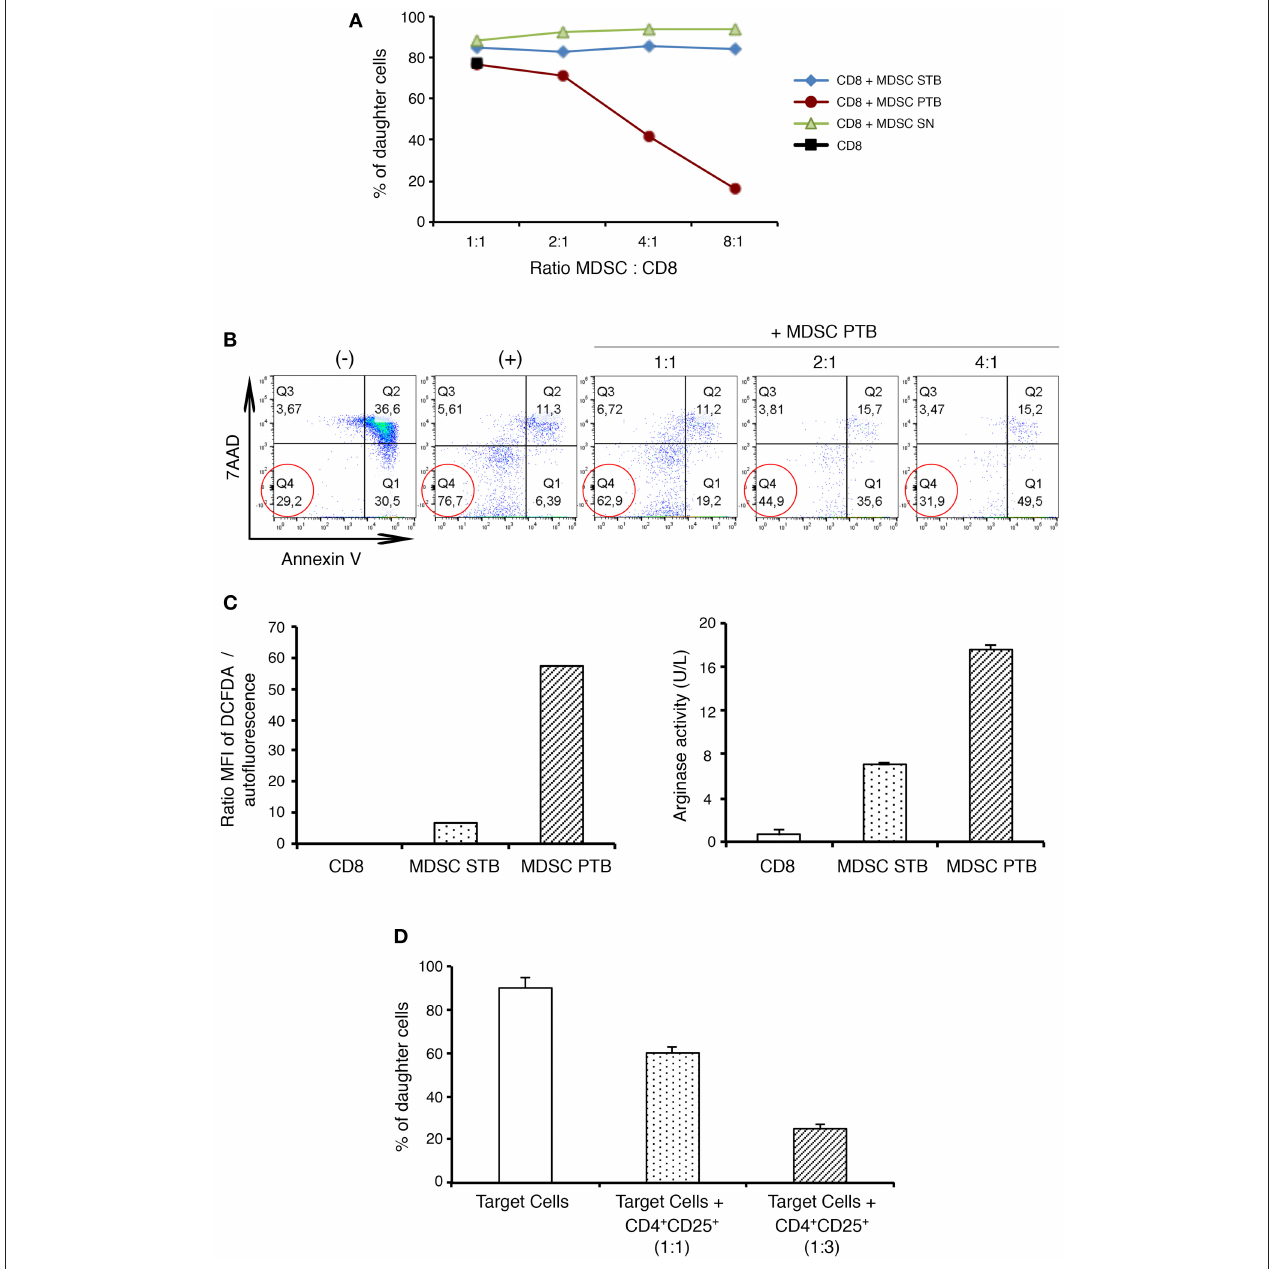
FIGURE 2 | Functional characterization of MDSCs and Treg cells in PDAC. CD8 + T cells proliferation is suppressed by tumoral MDSCs. (A) CFSE labeled CD8 + T cells were cultured with MDSCs isolated either from naive spleen (MDSC SN) or from tumor-bearing mice spleen (MDSC STB) or from tumor (MDSC PTB) at different ratios. The percentage of CD8 + daughter cells was evaluated by flow cytometry after 48h of culture with CD3/CD28 stimulation. (B) Tumoral MDSCs induce the death of CD8 + T cells ex vivo . CD8 + T cells were stimulated by CD3/CD28 and cultured with MDSCs isolated from tumor (MDSC PTB). Lymphocytes were then stained with cell death markers such as 7AAD and Annexin V. (–) no stimulation; ( + ) CD3/CD28 stimulation. (C) Production of ROS and arginase by MDSCs isolated either from the spleen (MDSC STB) or the tumor (MDSC PTB) of PDAC mice. CD8 + T cells were used as control. Cell lysates were analyzed for arginase 1 activity by measuring the ability to convert L-arginine to urea as describe in Materials and Methods. ROS production was determined by the production of fluorescent DCFDA as described in Materials and Methods. (D) Naive CD4 + CD25 − T cells (Target cells) proliferation is suppressed by tumoral Tregs. CFSE labeled CD4 + CD25 − T cells were cultured with Treg (CD4 + CD25 + ) cells isolated from tumor. After 72h of culture in presence of CD3/CD28 stimulation the percentage of CD4 + daughter cells was evaluated by flow cytometry.